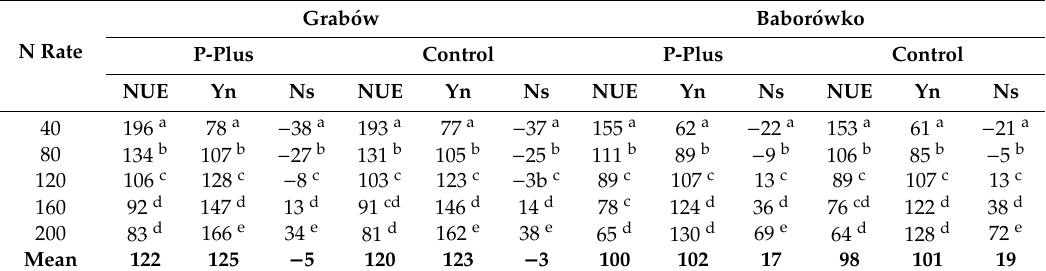
Table 6. N use indices for winter wheat; N fertilizer rate, Yn (uptake), Ns (surplus) (kg · ha − 1 ); NUE (%) for the P fertilizer addition (P-plus) and control (no P